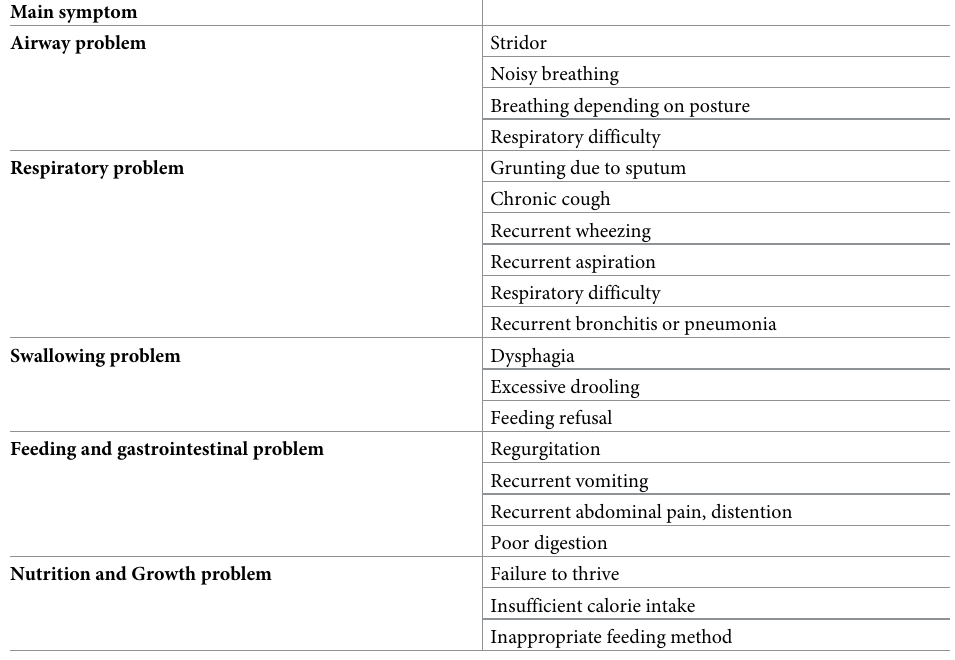
Table 2. Main problems showed and discussed with the patients and their families during the